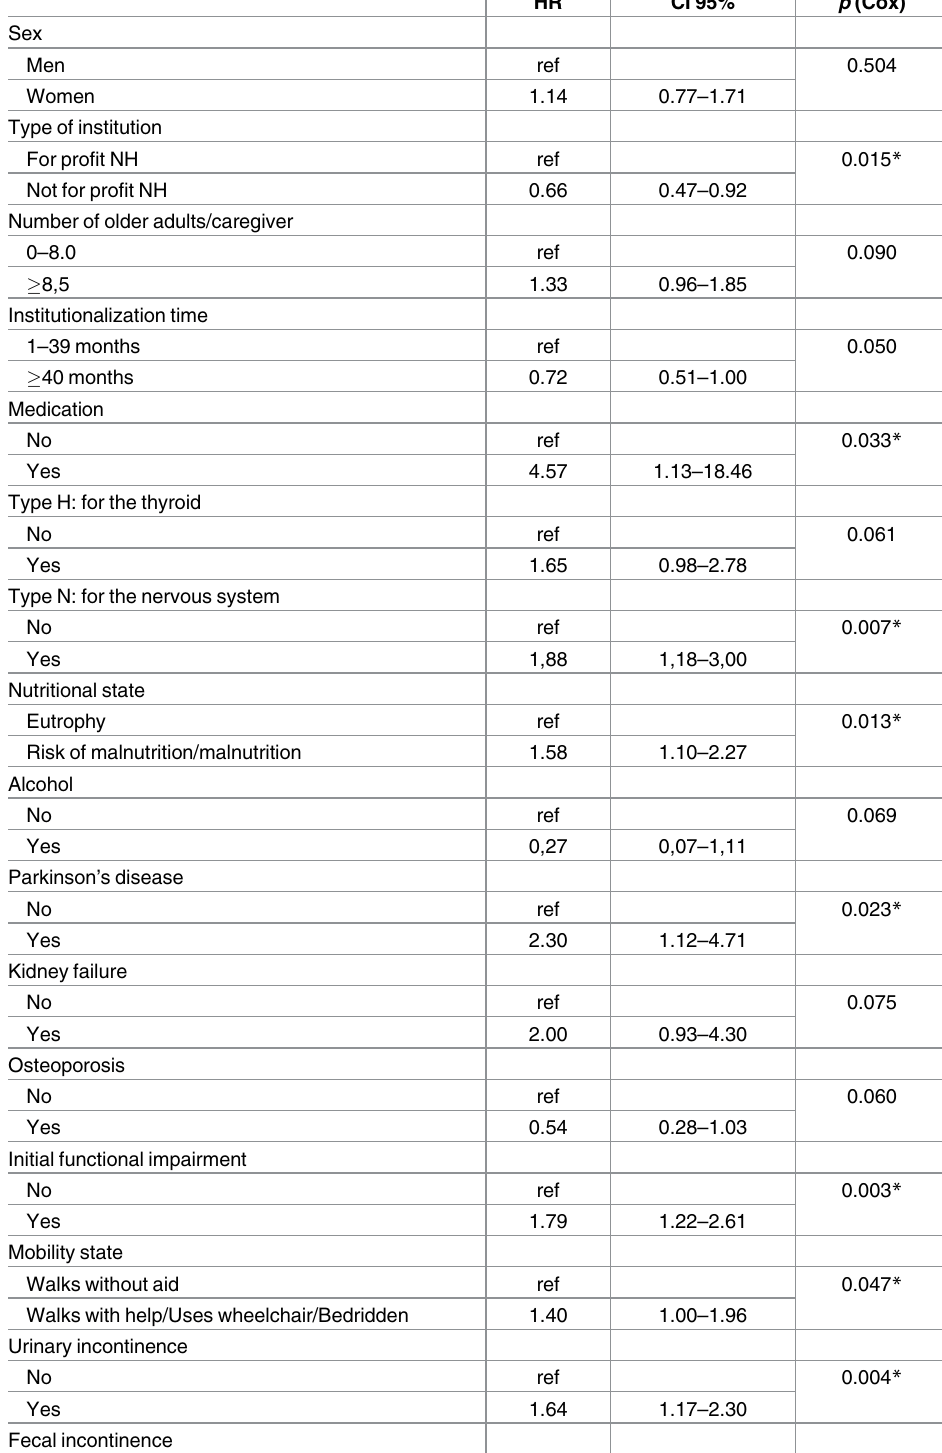
Table 4. Univariate analysisof covariablessex, as well as sociodemographic, related to the institution and health state variables with p < 0.10 that were not part of the multivariate model, regarding